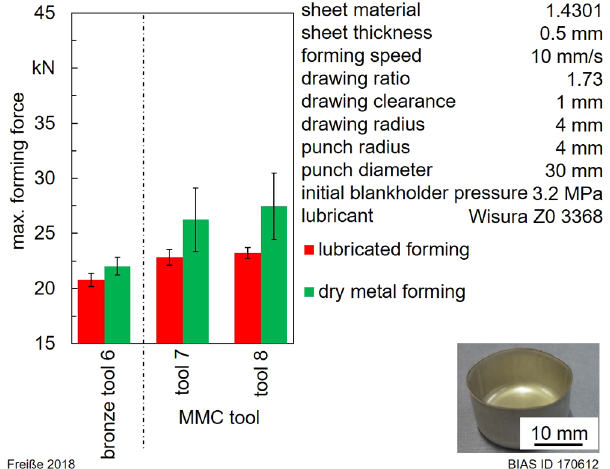
Fig. 21. Maximum forming forces using tools machined by die ‑ sinking EDM.